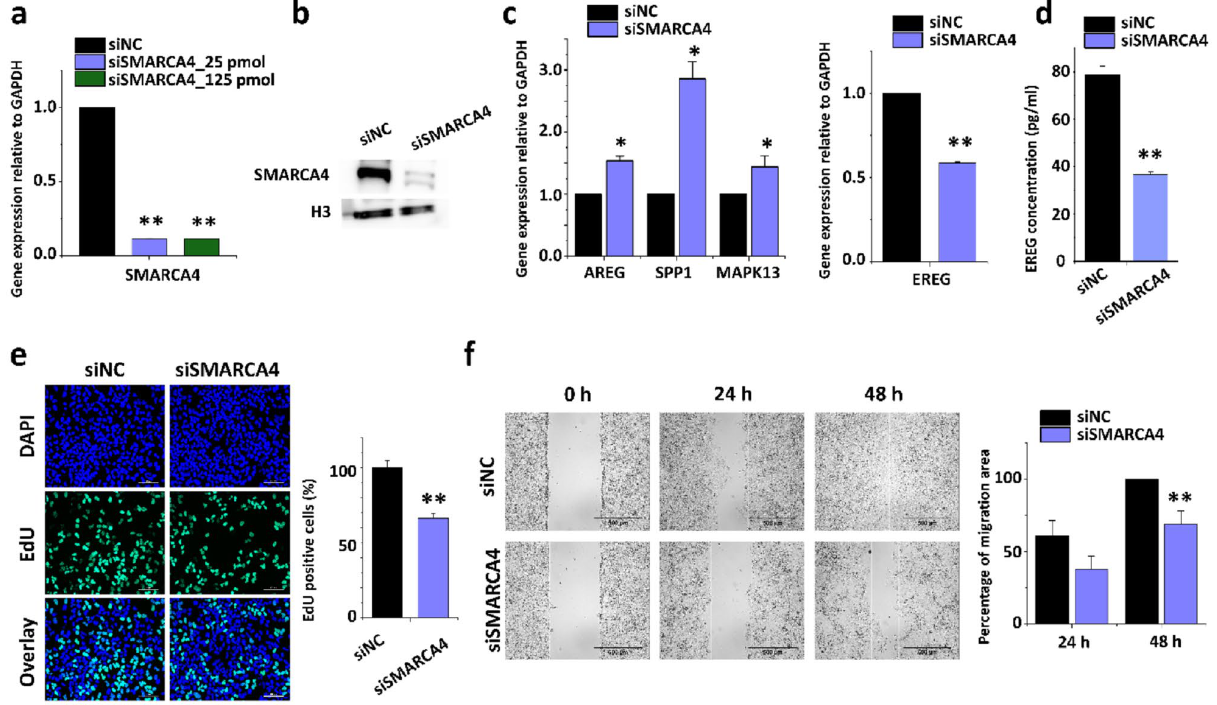
Figure 6. SMARCA4 regulated cell migration responses in HCC cells. ( a ) Quantitative PCRs were showing relative mRNA expression levels of SMARCA4 in scrambled siRNA control (n = 3) and SMARCA4 siRNA- treated HCC cells. Gene expression level was normalized to GAPDH. The values are the mean ± S.D. of triplicate well measurements. ** p < 0.01. ( b ) Western blot was showing down-regulated SMARCA4 protein levels in siRNA-treated HCC cells. ( c ) Confirmation of the expression levels of EREG, AREG, SPP1, and MAPK13 in SMARCA4 siRNA-treated HCC cells. The values are the mean ± S.D. of triplicate wells. * p < 0.05 and ** p < 0.01. ( d ) ELISA result showing the release of EREG upon repression of SMRACA4 expression. The values are means ± SD of triplicate wells. ** p < 0.01. ( e ) Effect of SMARCA4 siRNA on cell proliferation by EdU assay. The data represent three biologically, independent experiments. ** p < 0.01. ( f ) The migration of HCC cells was determined using a wound-healing assay. HCC cells migrated after 24 h and 48 h of SMARCA4 siRNA- treatment. The area filled with HCC cells that entered the middle blank fields was calculated. The data represent three biologically independent experiments. ** p <